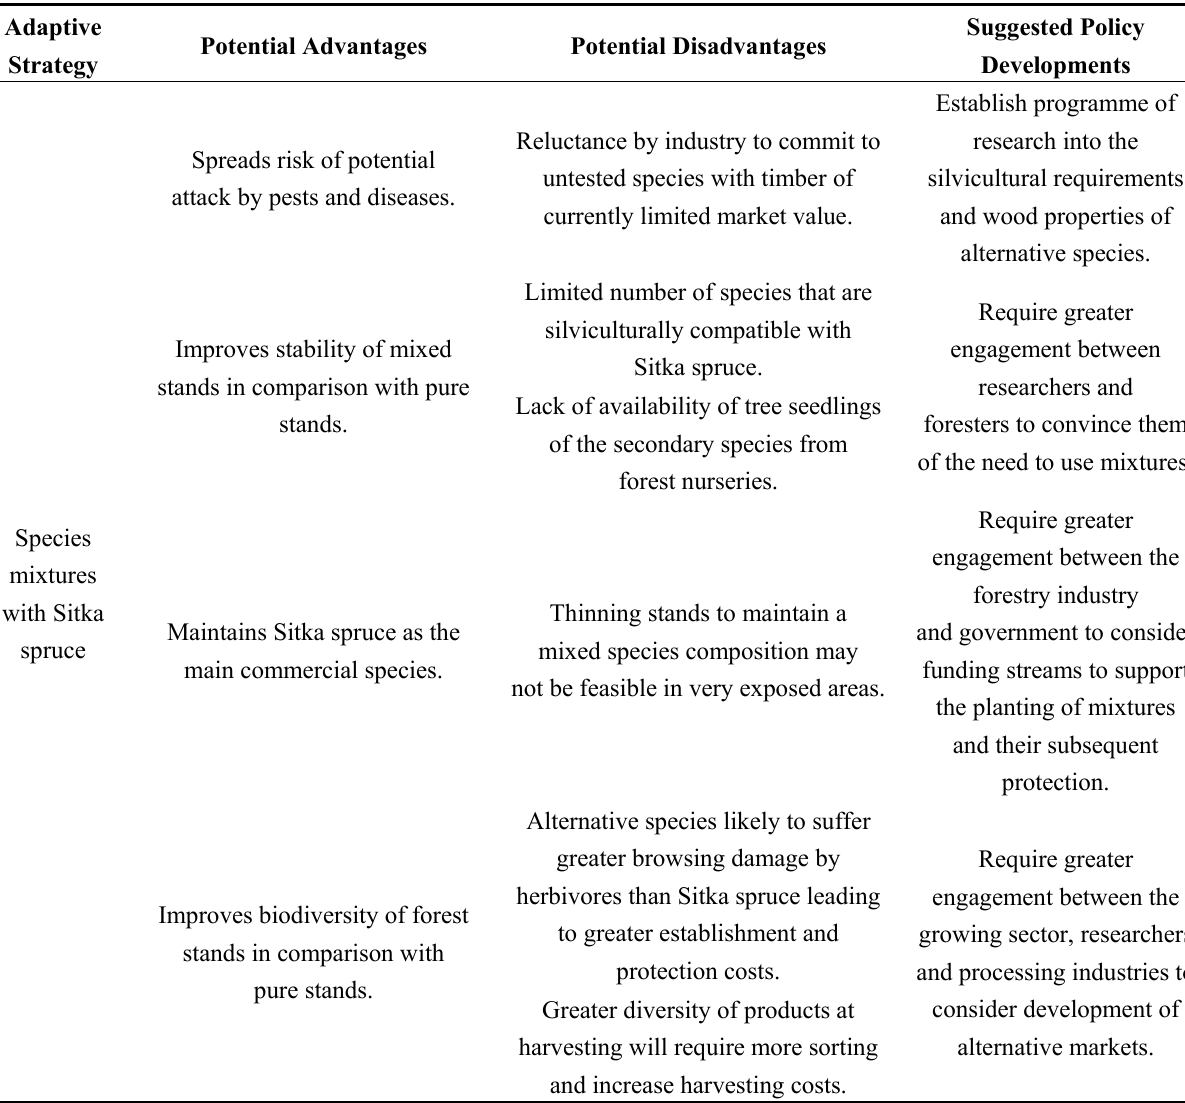
Table 1. Potential advantages and disadvantages of adaptive strategies to improve the resilience of Sitka spruce in response to climate change, and suggested policy developments to enable their